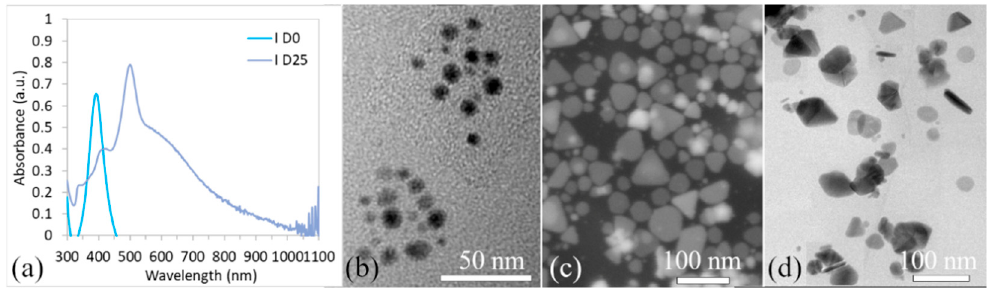
Figure 3. UV–vis spectra of the AgNPs colloid (I sample) for the day of synthesis (D0) and day 25 (D25) ( a ); AgNPs TEM micrographs at D0 ( b ) and TEM and SEM micrographs at D25 ( c,d ) .